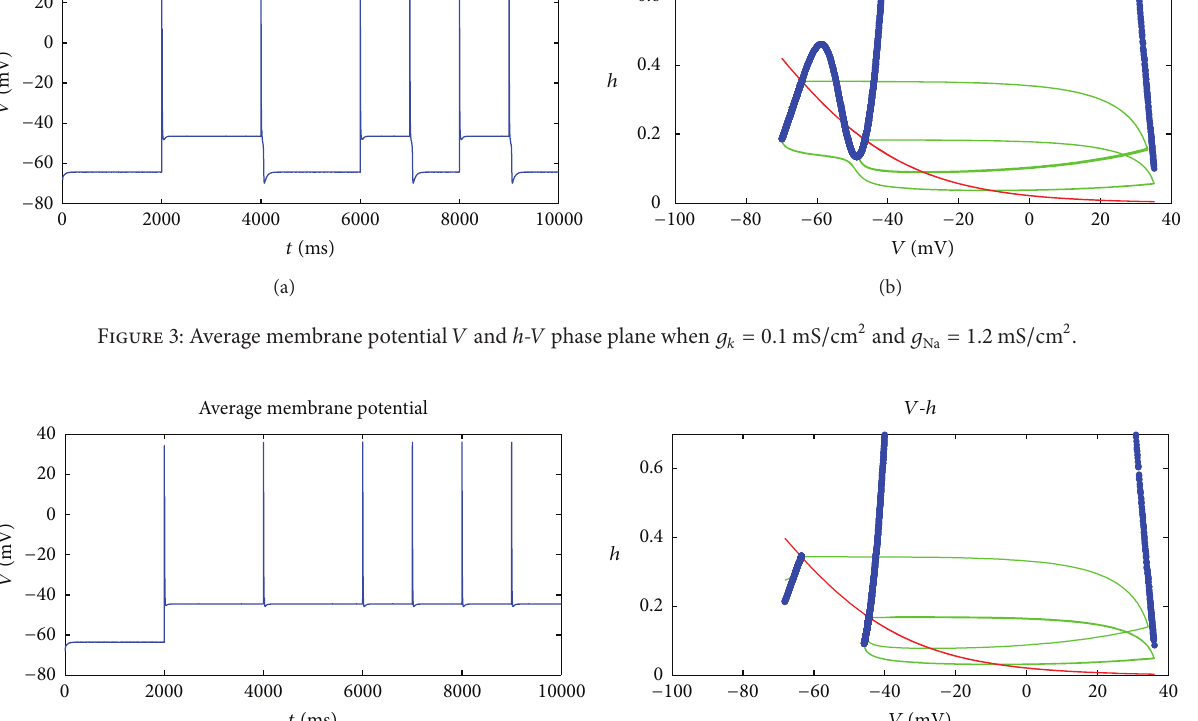
Figure 4: Average membrane potential 𝑉 and h-V phase plane when 𝑔 𝑘 = 0.09 mS / cm 2 and 𝑔